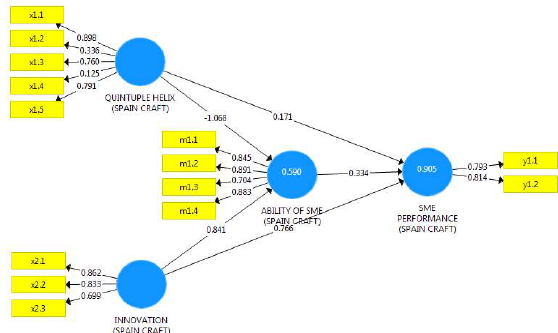
Fig. 6. Initial model Spain craft subsector